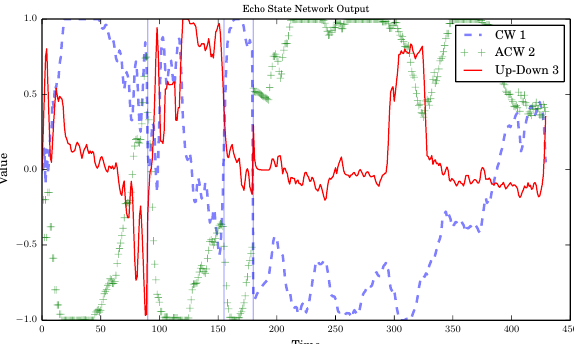
Figure 4. Usage of a trained ESN. The plot highlights how the geometrical properties of the input sequences are retained on the output of the network. The antagonistic behaviour between Clockwise (CW) and Anticlockwise (ACW) behaviours is shown, while the Up-Down motion recognition remains unaffected. In the graph the output of the network is depicted, with each colour and line style representing a pattern recognised in the input. All values are plotted against